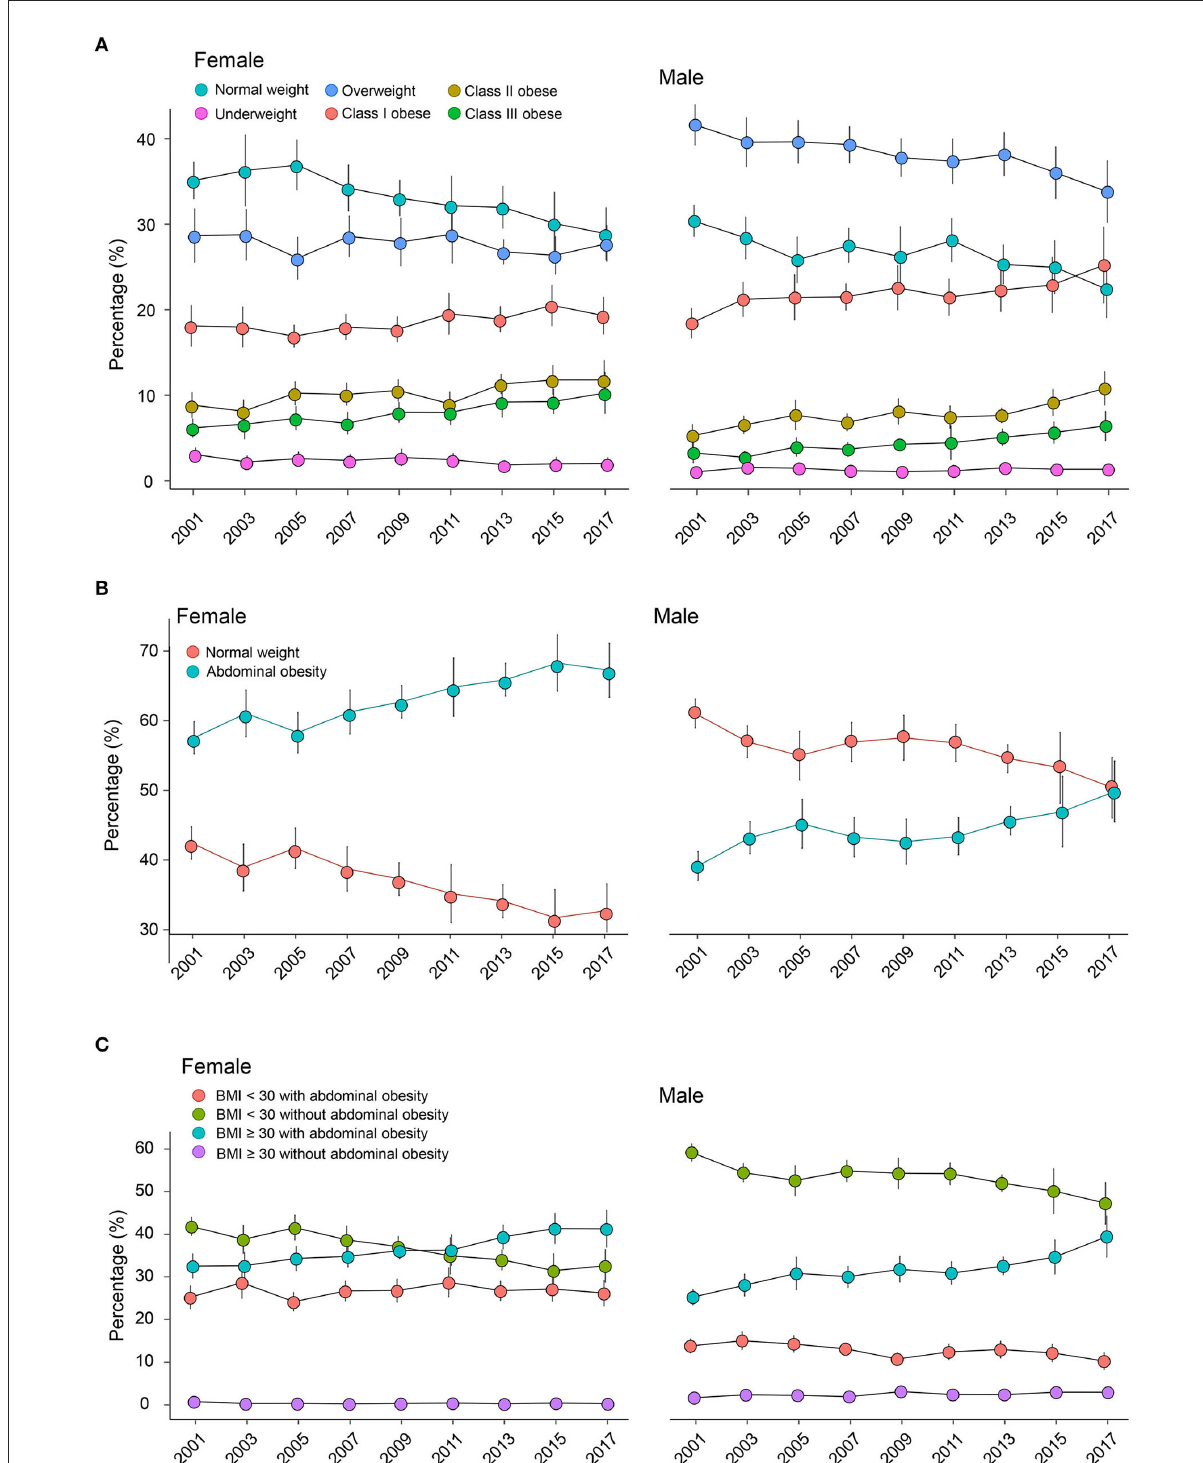
FIGURE2 Weighted age-adjusted prevalence trend with a 95% confidence interval of (A) general obesity, (B) abdominal obesity, and (C) combined obesity during 2001–2018 in females and males. Obesity is classified based on the World Health Organization criterion: underweight ( < 18.5 kg/m 2 ), normal weight (18.5–24.9 kg/m 2 ), overweight (25–29.9 kg/m 2 ), class I obese (30–34.9 kg/m 2 ), class II obese (35–39.9 kg/m 2 ), and class III obese ( ≥ 40 kg/m 2 ). Females with waist circumference ≥ 88cm and males with ≥ 100cm are identified with abdominal obesity. The combined obesity is defined according to the combination of BMI and waist circumference: BMI < 30 with abdominal obesity; BMI < 30 without abdominal obesity; BMI ≥ 30 with abdominal obesity; BMI ≥ 30 without abdominal obesity. BMI, body mass index